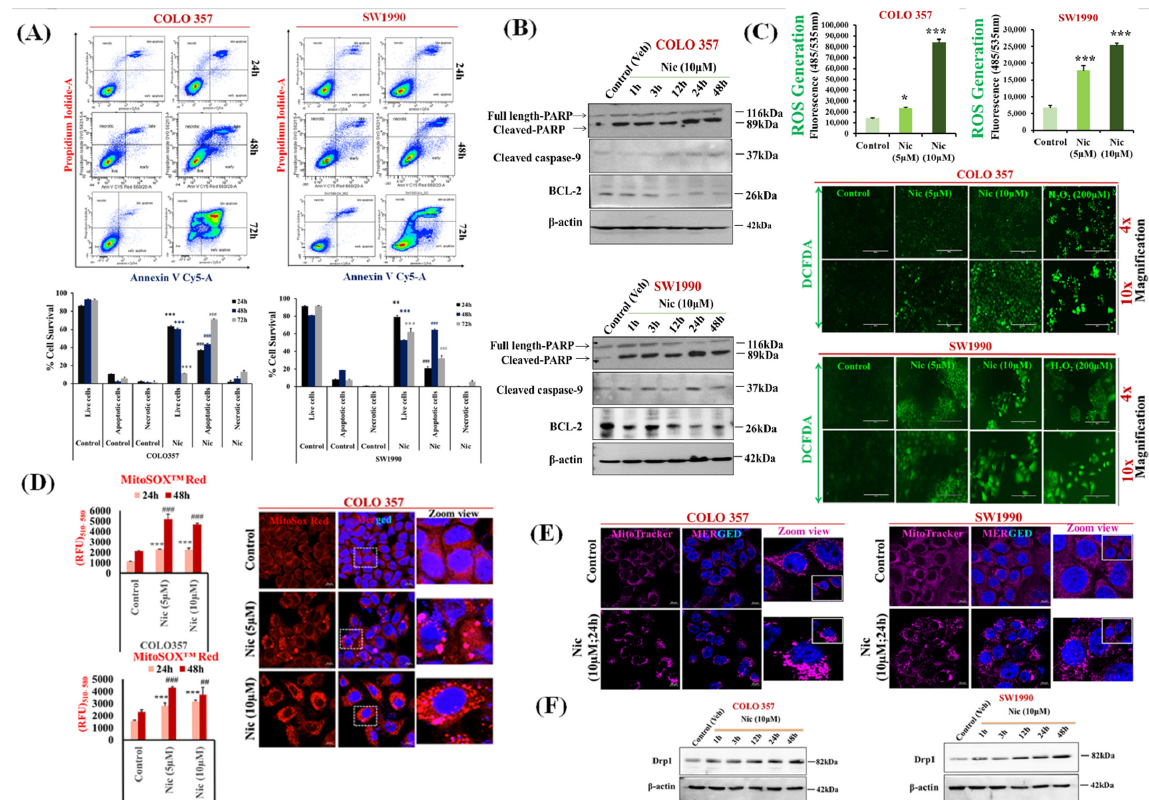
Figure 2. Nic increases intracellular and mitochondrial reactive oxygen species and promotes mitochondrial fragmentation resulting in PC cell apoptosis. ( A ) COLO 357 and SW1990 PC cells were treated with Nic (10 μ M) for different time points (24, 48, and 72 h) and apoptosis was determined by flow cytometric analysis of annexin-V Cy-5/PI- dual stained cells (AV + /PI–intact cells; AV/PI + –nonviable/necrotic cells; AV + /PI and AV + /PI + —apoptotic cells) in PC cell lines, i.e., COLO 357 and SW1990 (upper panel). Quantitative analysis of these micrographs were shown as mean ± SEM ( n = 3), p values: *** p < 0.001, ** p < 0.01 vs. live control cells; ### p < 0.001, ## p < 0.01 vs. apoptotic control cells ( lower panel). ( B ) Representative Western blot images showing the expression of apoptotic markers such as cleaved-PARP, total PARP, cleaved caspase 9, and BCL-2 at different time points (1, 3, 12, 24, and 48 h) in COLO 357 and SW1990 cells treated with Nic (10 μ M). β - actin is used as an internal loading control. ( C ) Intracellular ROS levels in PC cells treated with Nic (5 μ M and 10 μ M for 24 h) was evaluated using DCFDA fluorogenic dye (10 μ M for 30 min) by measuring fluorescence at 485/535 nm (excitation/emission) using a fluorescent plate reader. The results were expressed as relative fluorescence intensity units. Values are expressed as mean ± SEM ( n = 3), p values: *** p < 0.001, * p < 0.05 vs. control ( upper panel). Fluorescence imaging was done in these cells stained with DCFDA and cells with higher green fluorescence showed higher cellular ROS accumula- tion (lower panel). ( D ) Mitochondrial ROS/mitochondrial superoxide levels were assessed using MitoSox Red probe (5 μ M for 30 min) by measuring fluorescence at 510/580 nm (excitation/emission) using a fluorescent plate reader after PC cells treated with Nic (5 μ M and10 μ M) for 24 and 48 h. The results were expressed as relative fluorescence intensity units. Values are expressed as mean ± SEM ( n = 3), p values: *** p < 0.001, * p < 0.05 vs. control (left panel). Representative image of MitoSOX red staining of superoxide radicals in Nic treated COLO 357 cells for 24 h by confocal microscopy (right panel). ( E ) Mitochondria fragmentation was determined by using Mito-tracker Red (100 nm for 30 min) in COLO 357 and SW1990 cells treated with Nic (5 μ M and 10 μ M) for 24 h. ( F ) Representative Western blot images showing the expression pattern of mitochondria fission protein Drp1 at different time points (1, 3, 12, 24, and 48 h) in COLO 357, SW1990 cells treated with Nic (10 μ M). Membrane was stripped and re-probed with β -actin as an internal loading control.